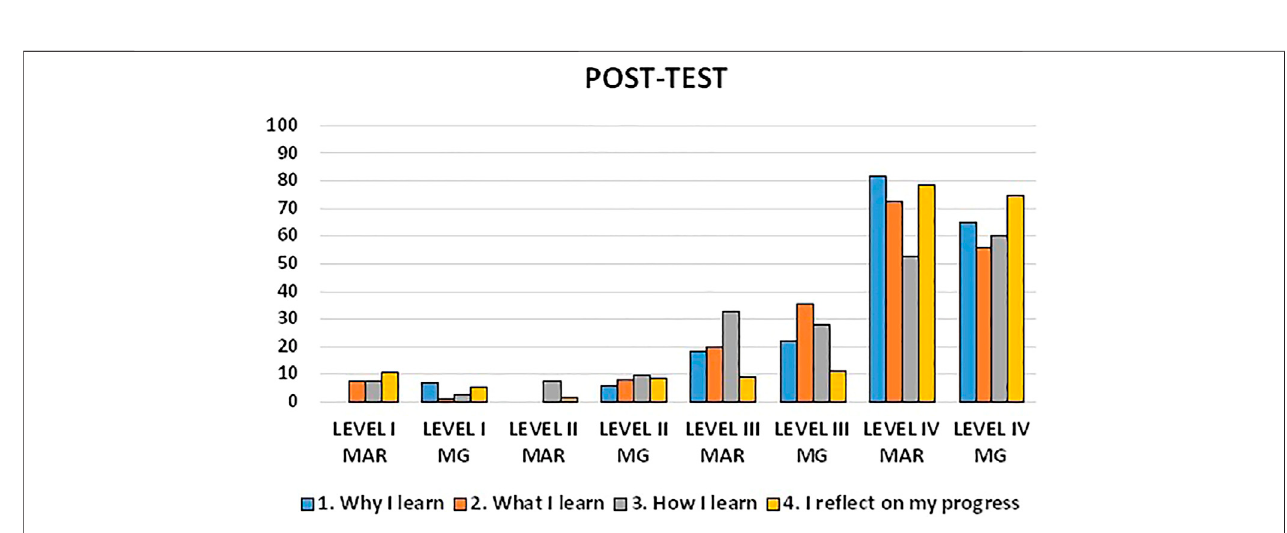
FIGURE 9 | MAR vs. MG (posttest): levels of achievement of the four